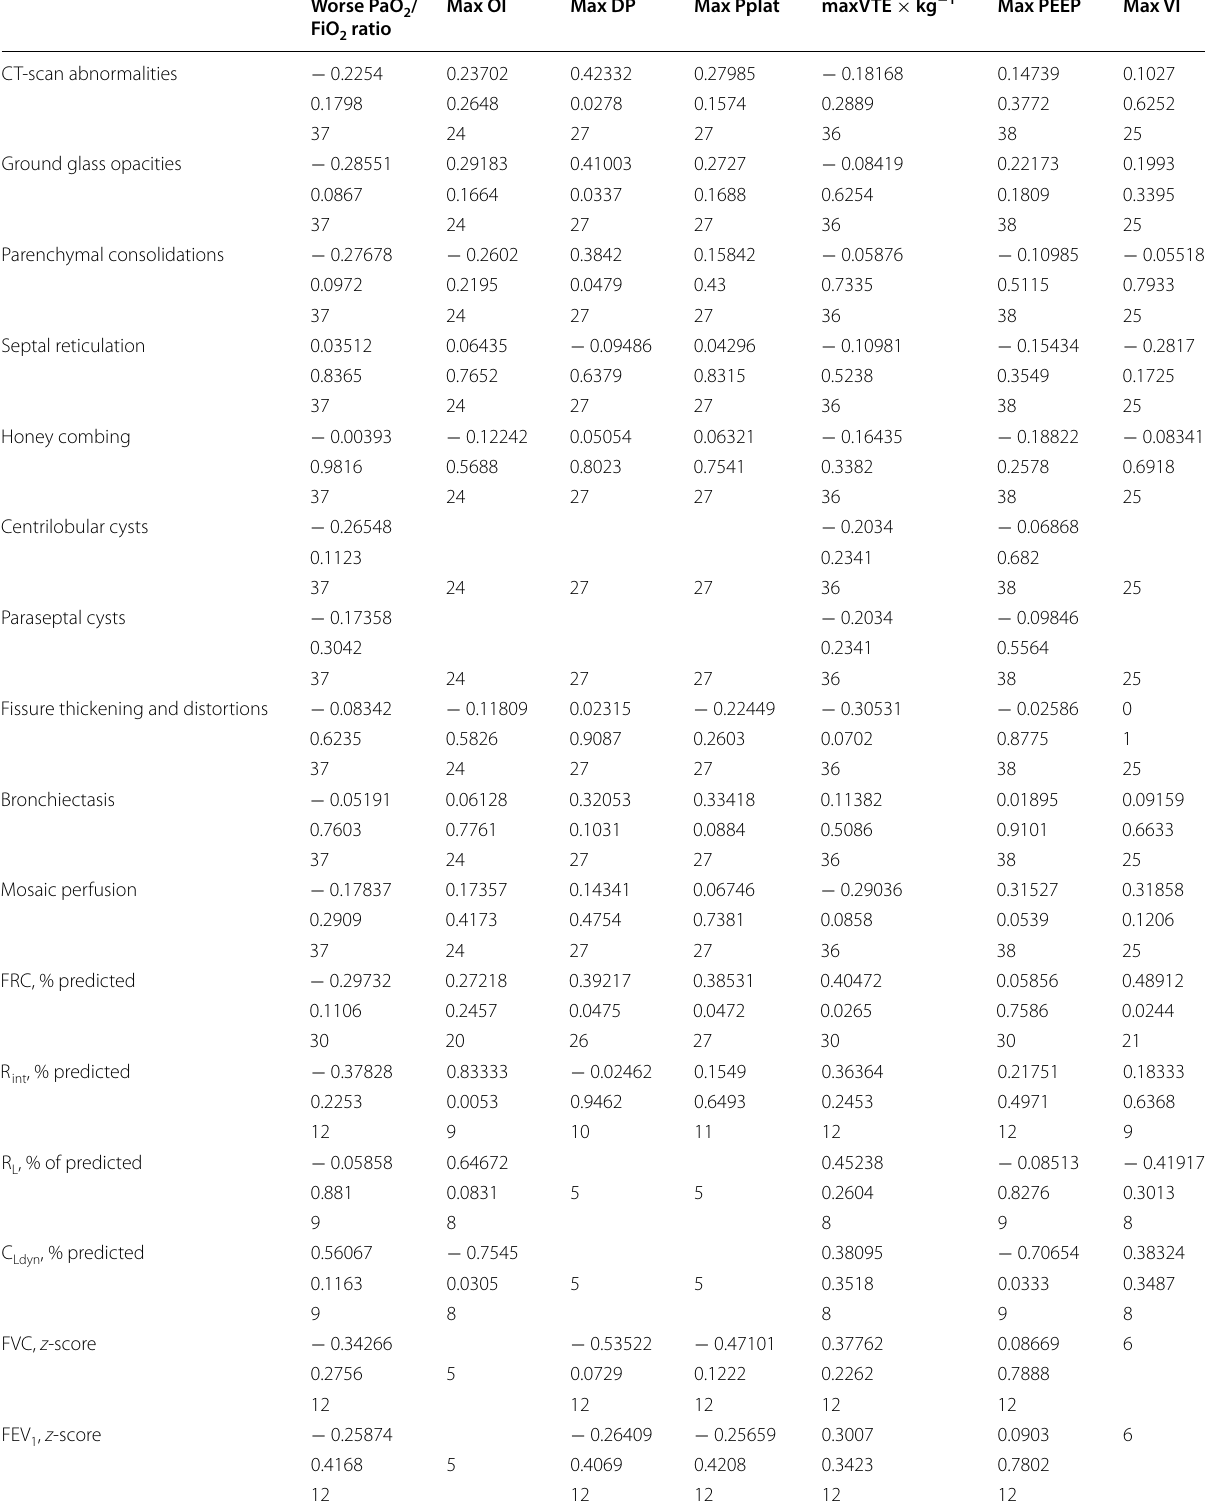
Table 6 Correlation matrix (spearman correlation) of physiologic parameters/ventilator settings, CT scan, and